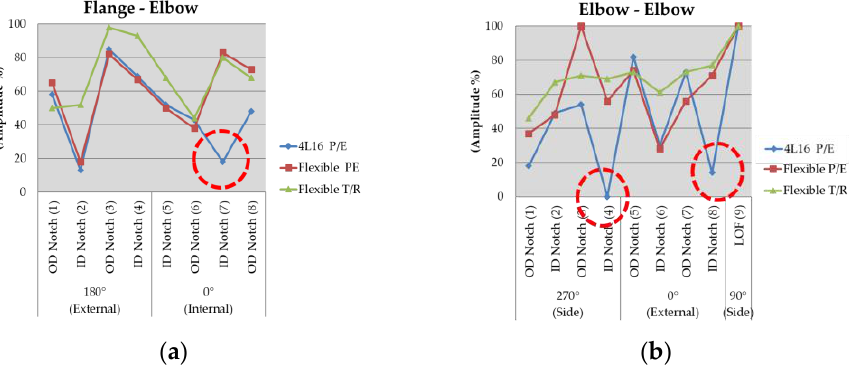
Figure 21. Flange – elbow – elbow specimen inspection results: ( a ) flange to elbow; ( b ) elbow to elbow. Figure 21. Flange–elbow–elbow specimen inspection results: ( a ) flange to elbow; ( b ) elbow to